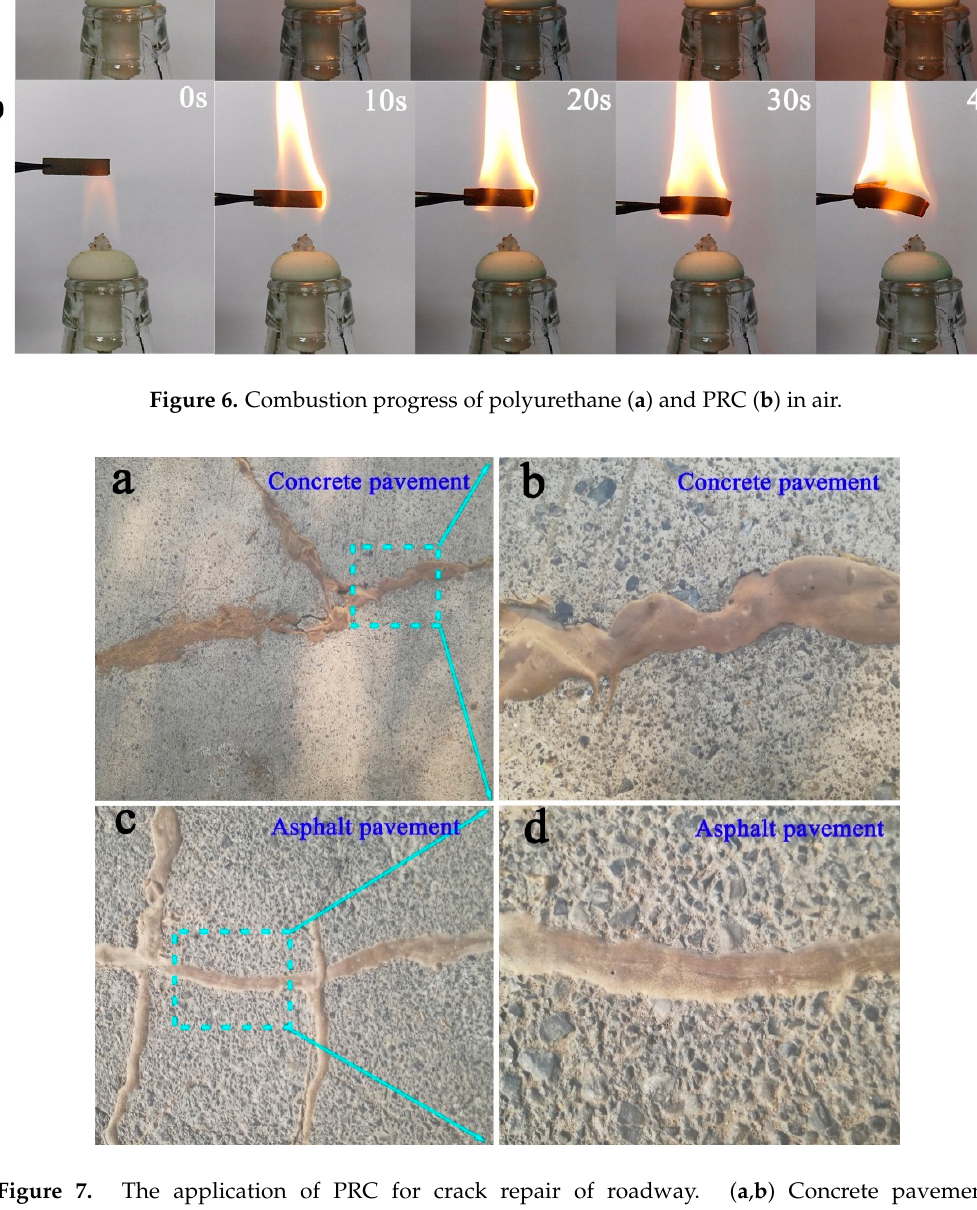
Figure 7. The application of PRC for crack repair of roadway. ( a , b ) Concrete pavement, ( c , d ) Asphalt pavement.